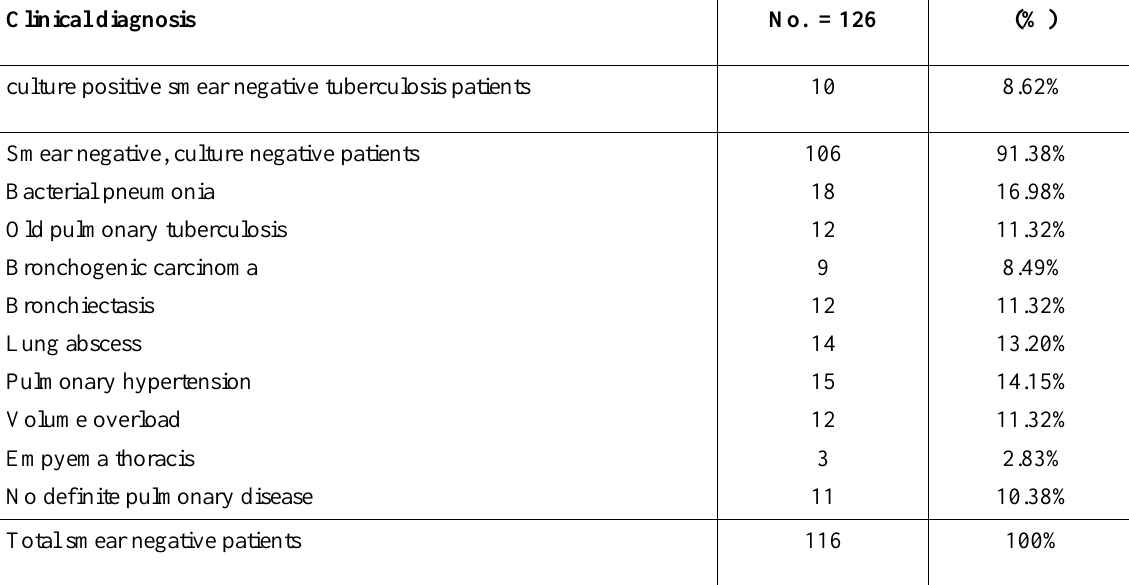
Table 2. Final clinical assessment of patients with smear negative